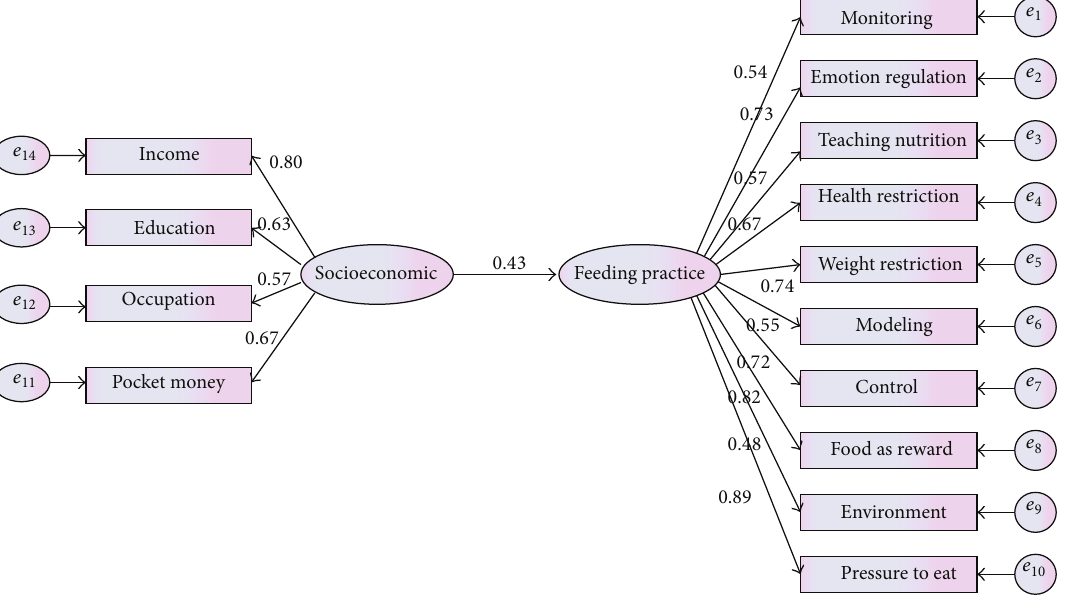
Figure 7: Standardized path coefficients and residual variance in the first model.